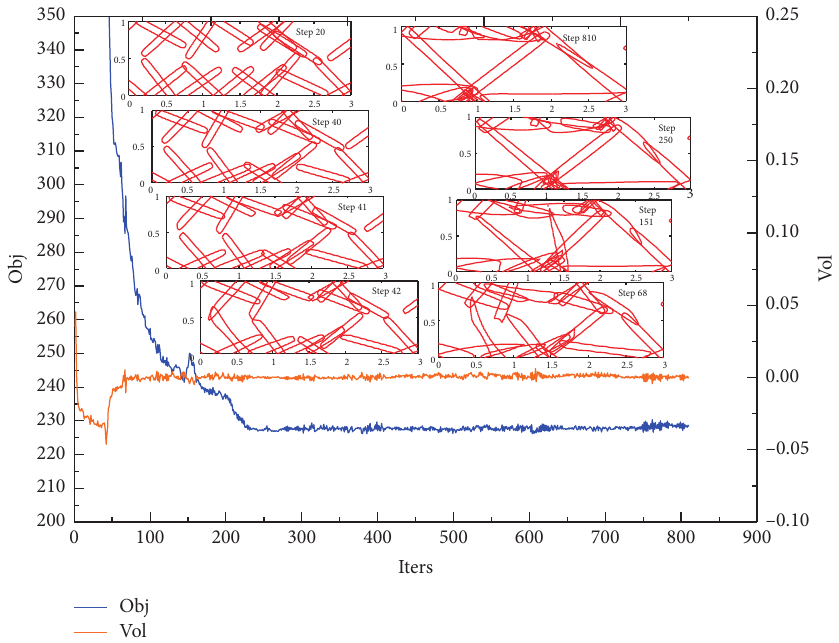
Figure 16: Convergence history of the MBB example using the paper Table 2: The data obtained from the MBB problem. Method